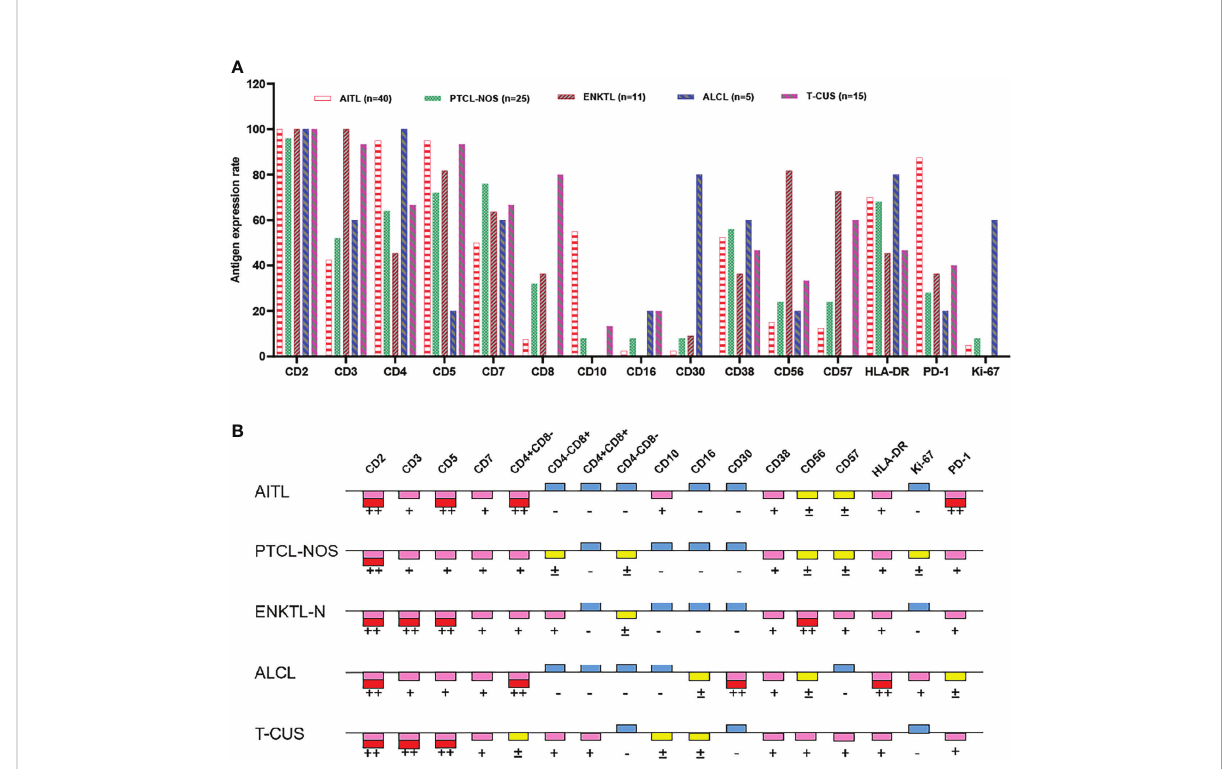
FIGURE 2 Expression pro fi les of immune markers for AITL, PTCL-NOS, ENKTL, ALCL, and T-CUS. (A) Proportion of positive expression of each antigen of 4 PTCL subtypes and T-CUS. (B) Antigen expression pro fi les of 4 PTCLs subtypes and T-CUS. ++, >75% of cases express this antigen; +, 25%-75% of cases express this antigen; ±, 10%-25% of cases express this antigen; -, <10% of cases express this